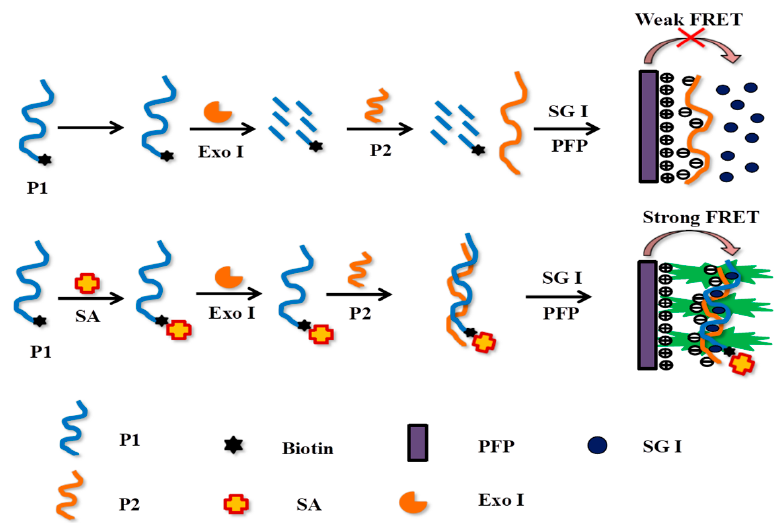
Scheme 1. Working principal of the SA detective strategy based on terminal protection-mediated fluorescence resonance energy transfer amplification.